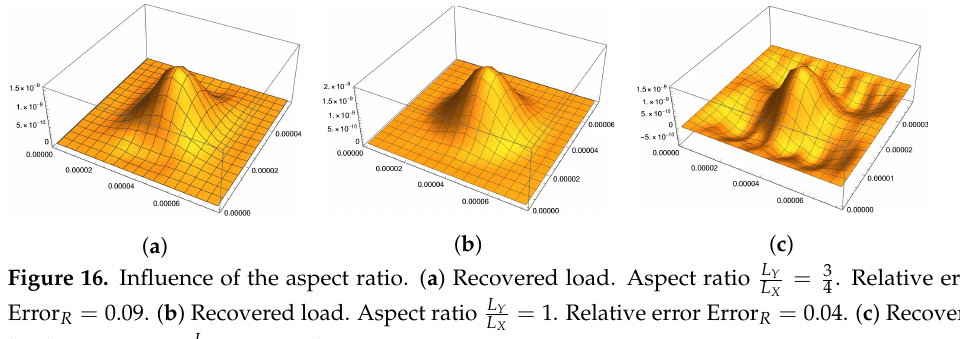
= 0.5. Relative error Error L X